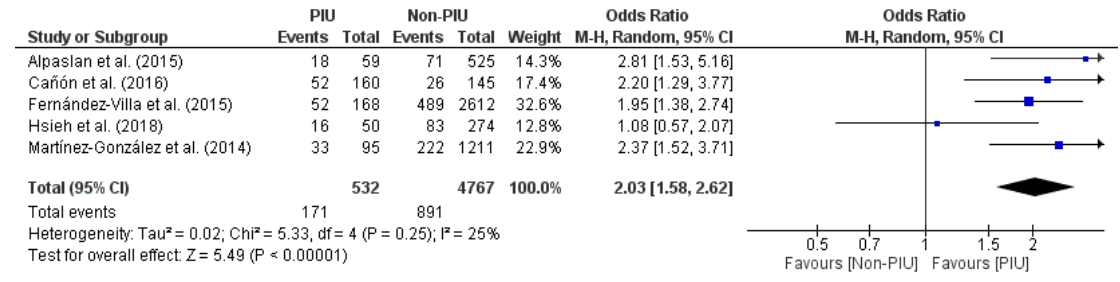
Figure 4. Forest plot of meta-analysis with dichotomous data.